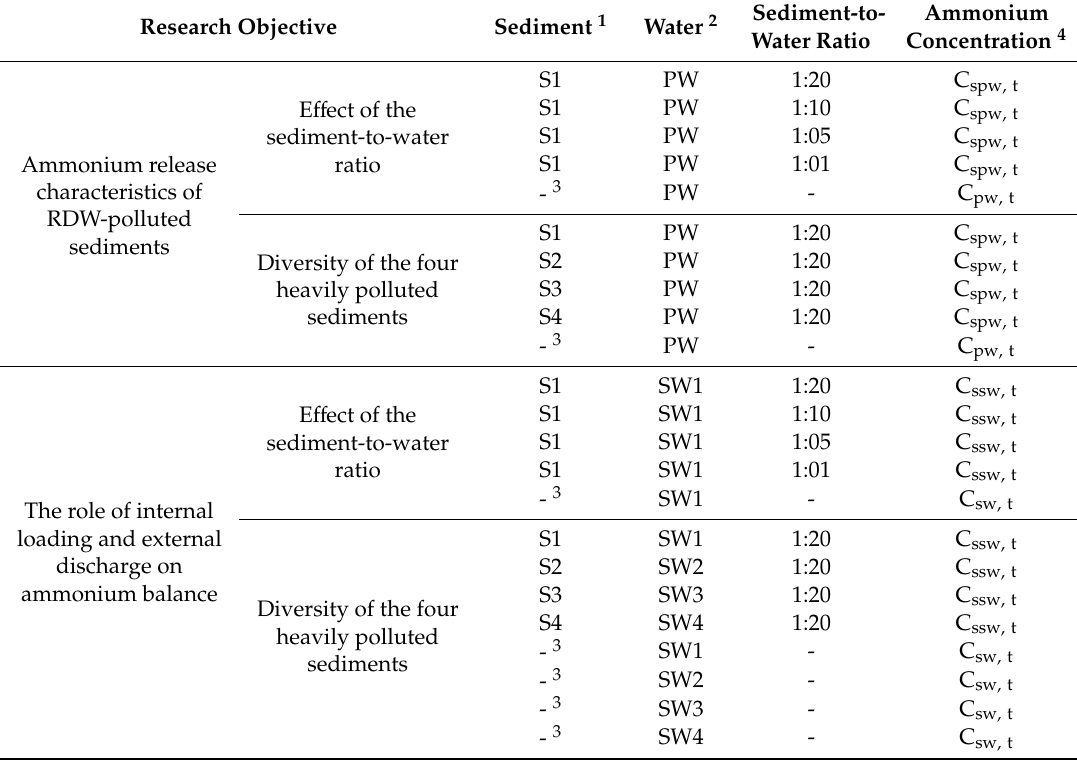
Table 2. The experimental design for incubation of long-term RDW-polluted sediments. Research